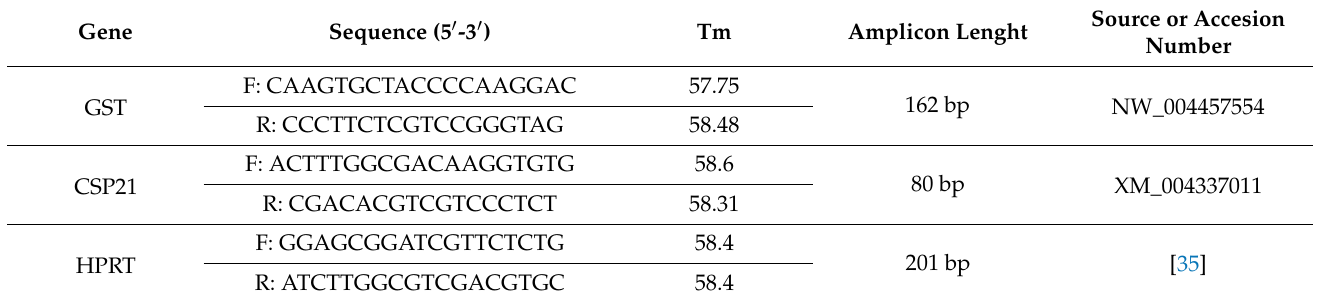
Table 1. qPCR primers and their